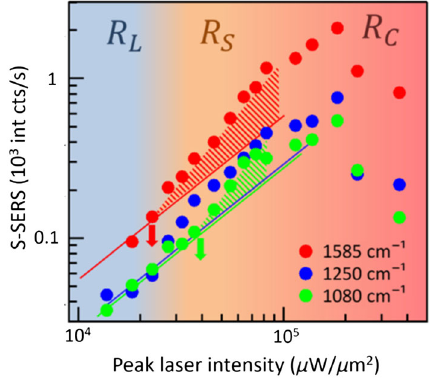
FIG. 3. Regimes for different molecular vibrations. SERS intensity of the 1585 cm − 1 , 1250 cm − 1 , and 1080 cm − 1 modes for BPT molecules forming the plasmonic spacer, as a function of the incident pulsed laser power: linear ( R ), superlinear ( R ), and L S driven chemical ( R ) regimes are highlighted in blue, orange, and C red, respectively. Lines show linear fits to the R regime; arrows L show